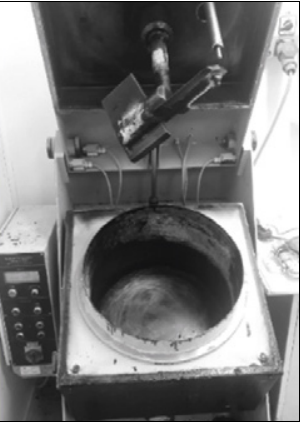
Figure 14. Mixer equipped with heating and temperature control